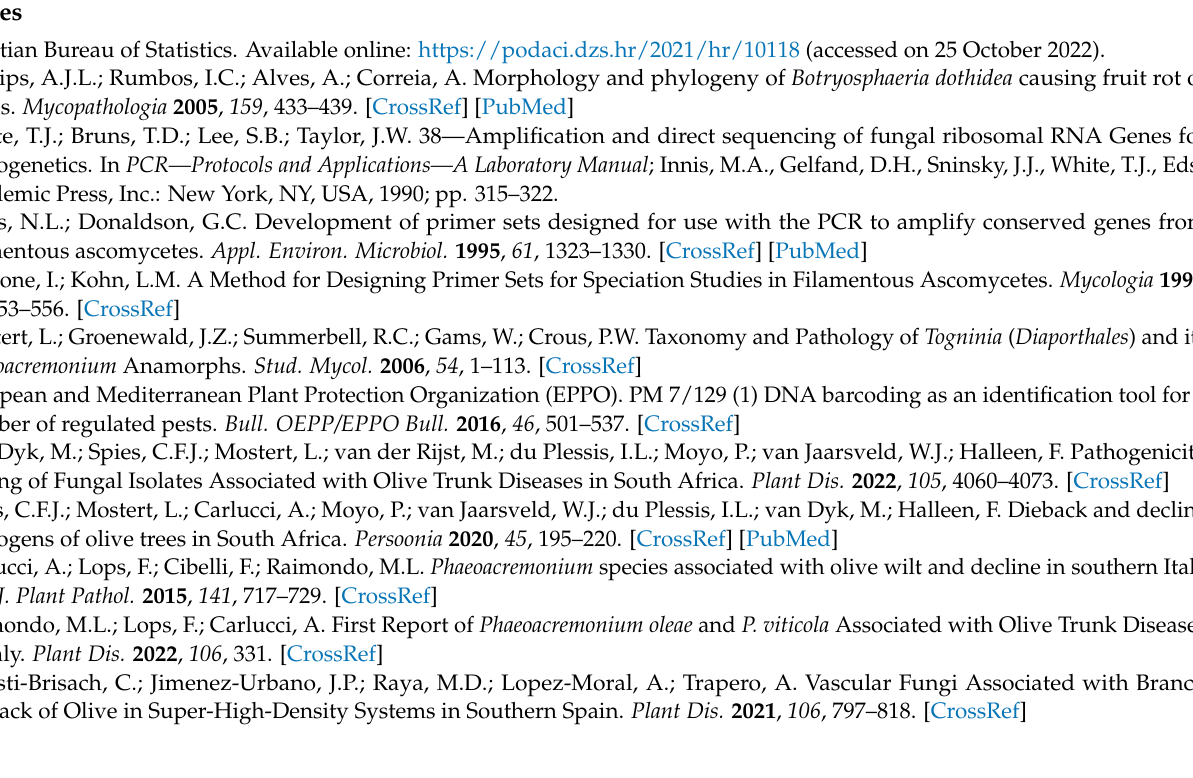
Table S1: PCR amplification program set according to Alves et al. (2006) [30]. Figure S1: Phylogenetic tree based on internal transcribed spacer (ITS) sequences alignment. The evolutionary history was inferred using the Neighbor-Joining method [31]. The optimal tree is shown. The evolutionary distances were computed using the Maximum Composite Likelihood method [32] and are in the units of the number of base substitutions per site. This analysis involved six nucleotide sequences. All ambiguous positions were removed for each sequence pair (pairwise deletion option). There was a total of 596 positions in the final dataset. Evolutionary analyses were conducted in MEGA11